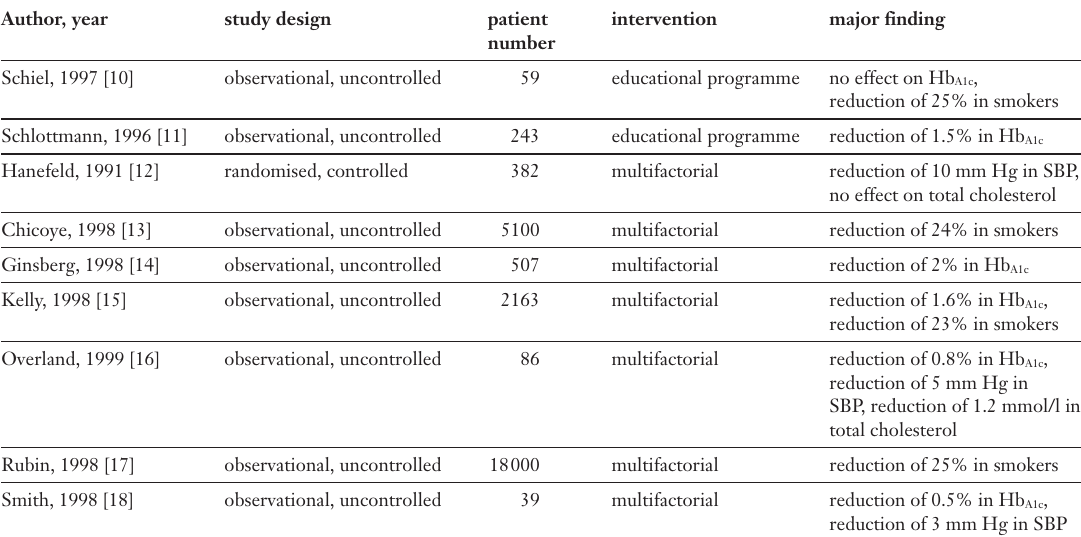
Overview of studies assessing the short- term effects of edu- cational programmes and multifactorial in- terventions on clini- cal